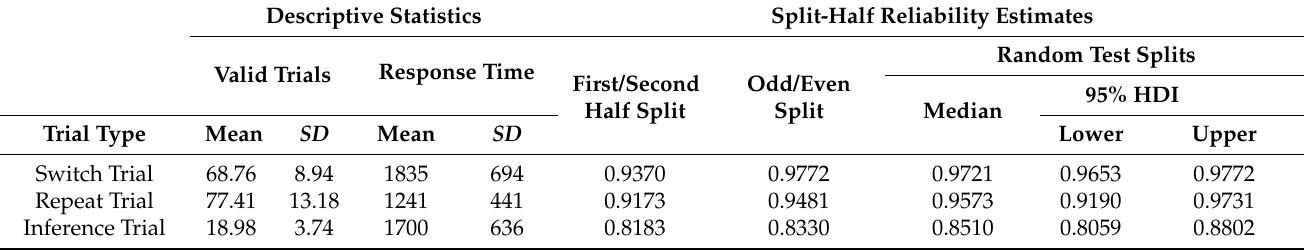
Table 2. Descriptive statistics and split-half reliability estimates for RT measures. SD = standard deviation; HDI = highest density interval. Response times in